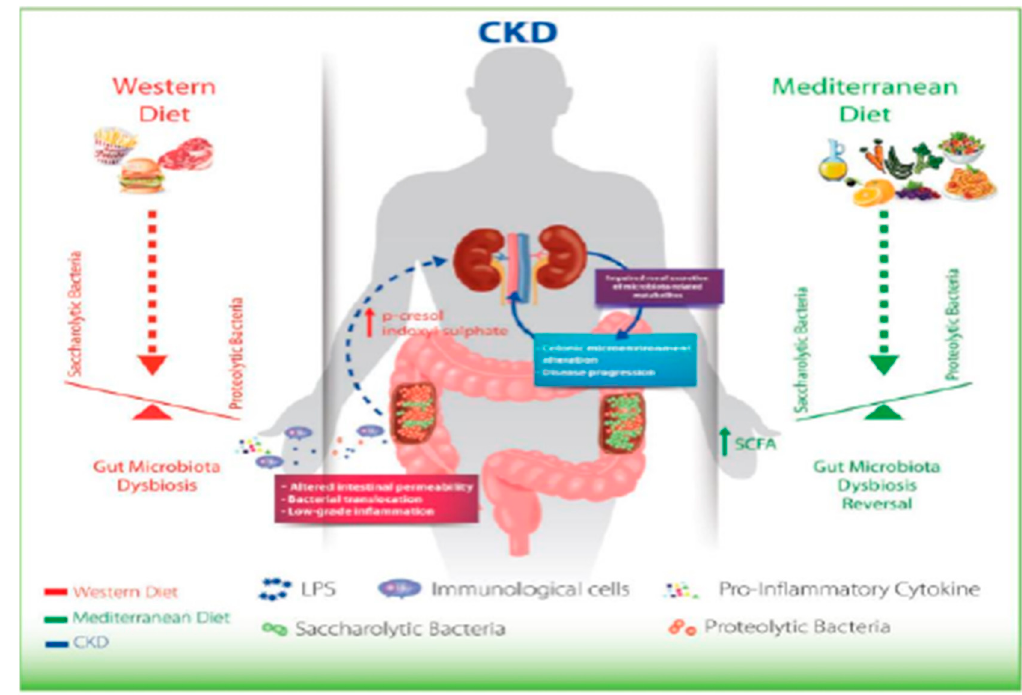
Figure 6. Montemurro et al., KBPR 2014.